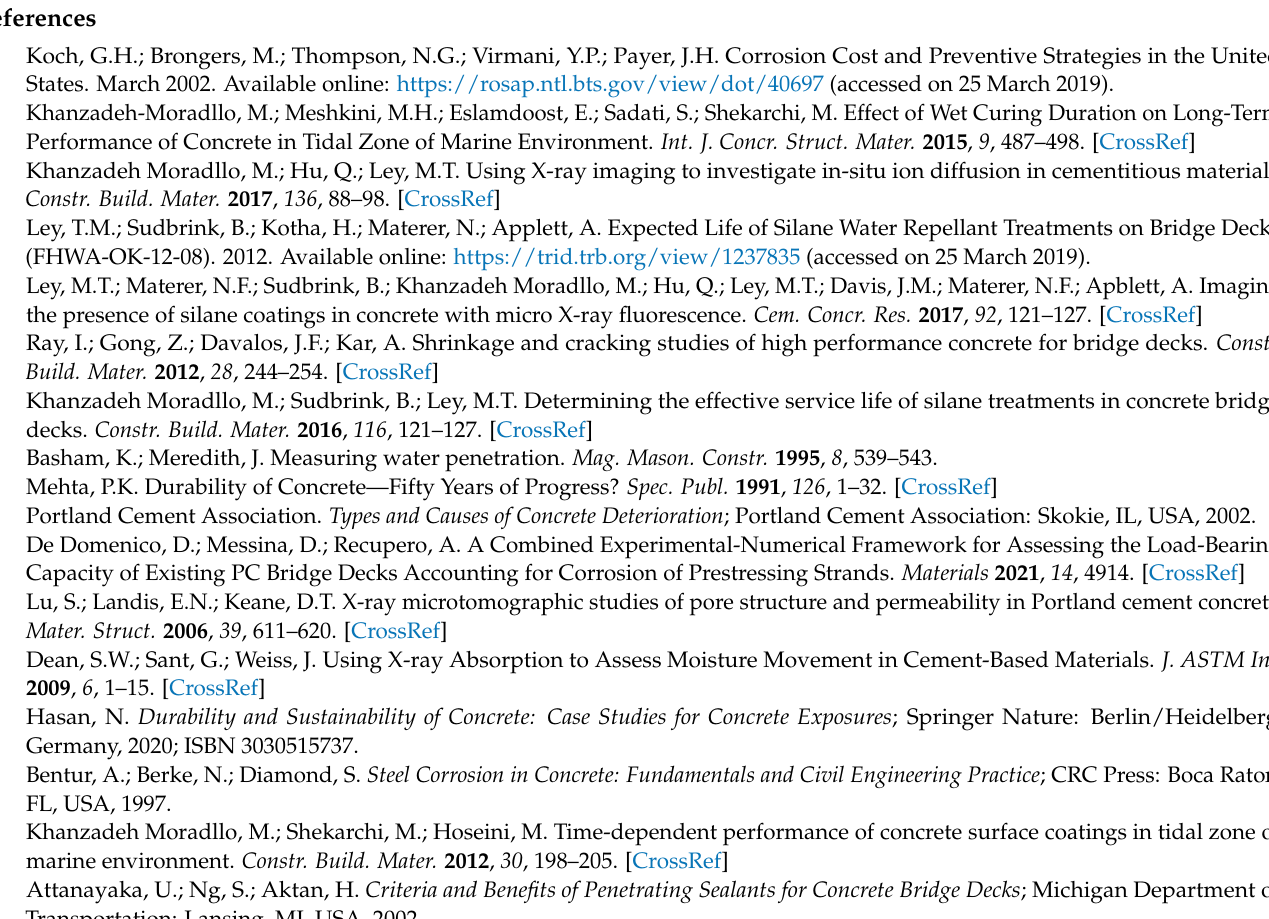
Figure A1. Iodide concentration profiles of all 14 samples.